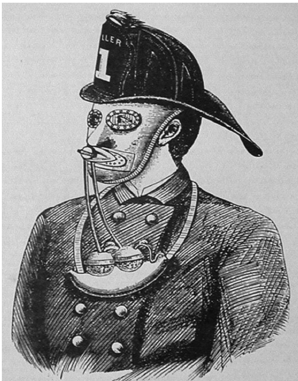
Figure 2. “Nearly” smoke mask created in 1877. Reproduced with permission from reference [26]. Copyright (2012), Elsevier .